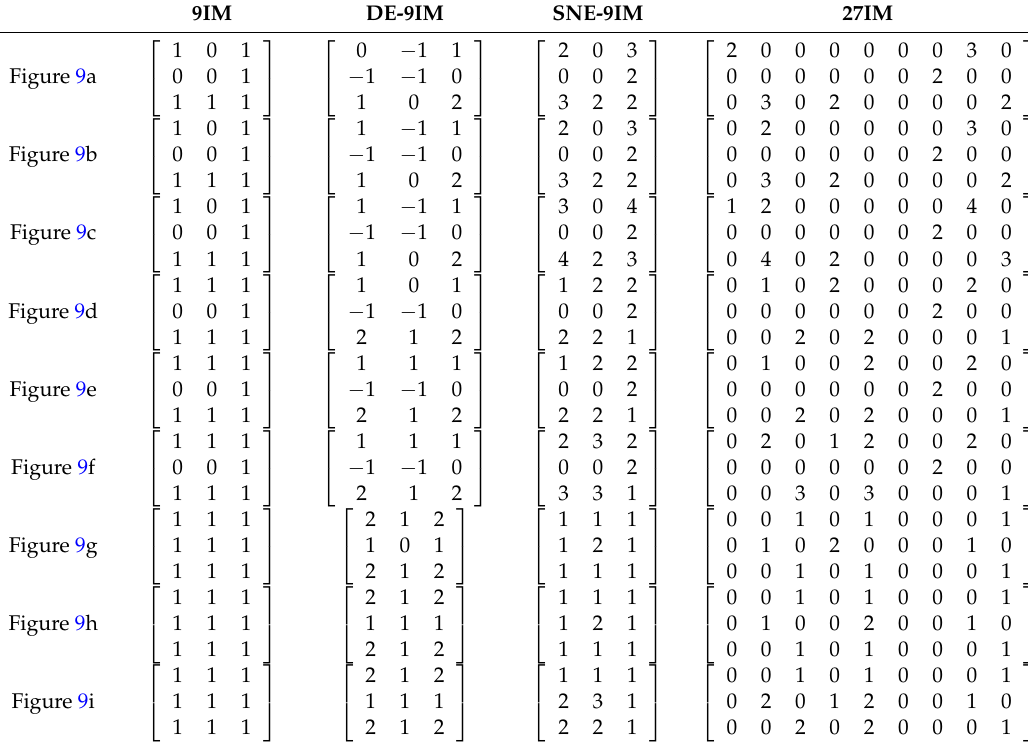
Table 2. Topological relation as described by the 9IM, dimensionally-extended nine-intersection matrix (DE-9IM), separation number extended nine-intersection matrix (SNE-9IM) and